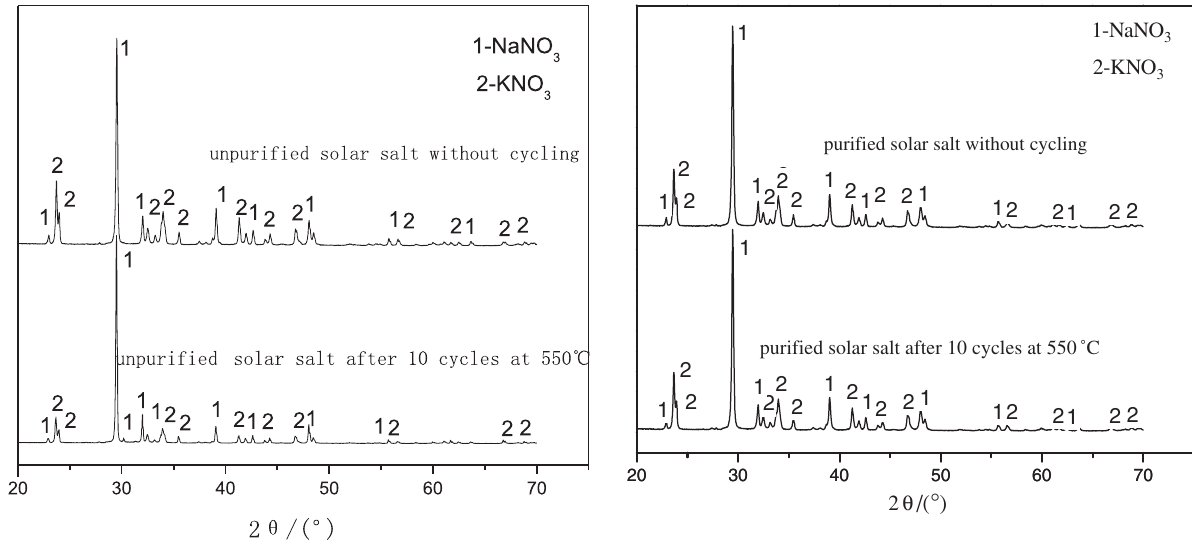
Figure 18: XRD pattern of purified Solar Salt after 10